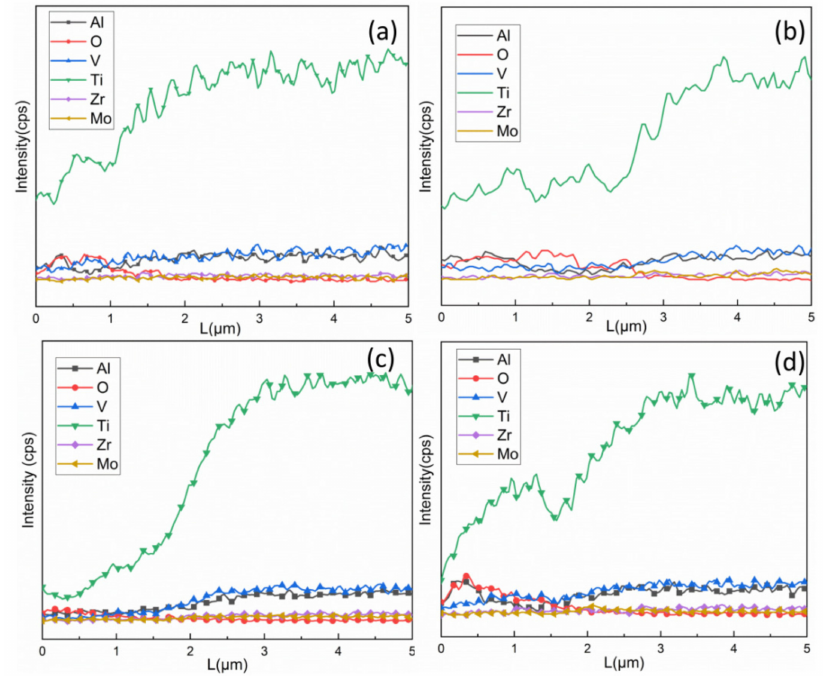
Figure 6. The contents of different elements change with depth at 800 ◦ C: ( a ) 0.5 h and ( b ) 2 h after mechanical grinding, ( c ) 0.5 h and ( d ) 2 h after laser